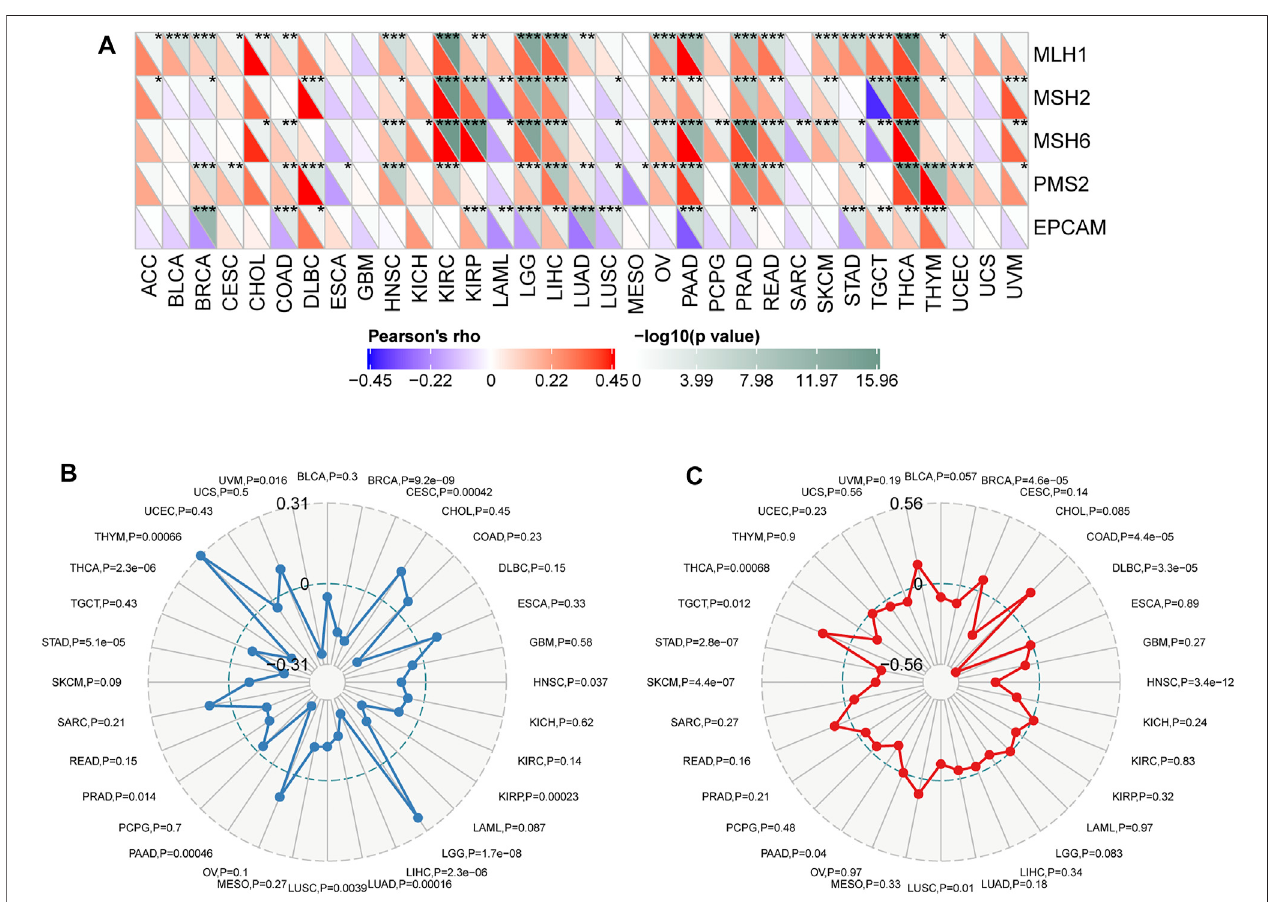
FIGURE 5 | Correlations between CD93 expression and MMR, TMB, and MSI in cancers. (A) Correlations between CD93 expression and MMR genes (* p < 0.05, ** p < 0.01, *** p < 0.001). (B) Correlations between CD93 expression and TMB across cancers. (C) Correlations between CD93 and MSI across cancers. The value in black reveals the range, and the curves in blue and red reveal the correlation coef fi